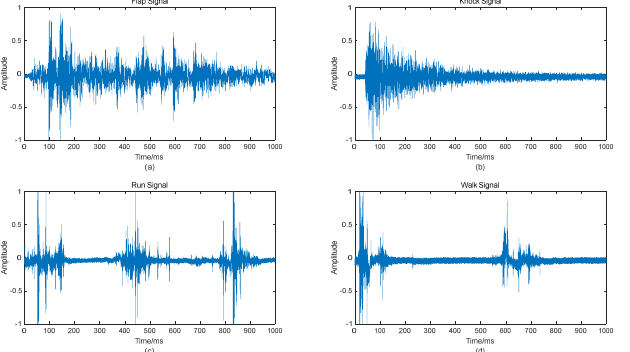
Figure 5. Four kinds of fiber vibration signals after preprocessing: ( a ) Flap signal; ( b ) knock signal; ( c ) run signal; ( d ) walk signal.